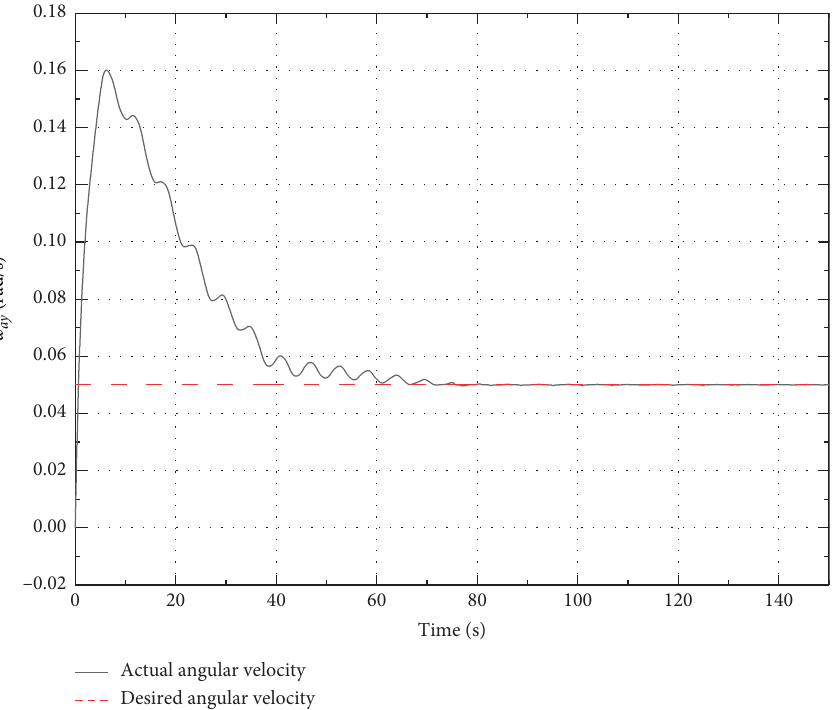
Figure 6: Trajectories of the y -axis flexible solar panel’s attitude angular velocity.